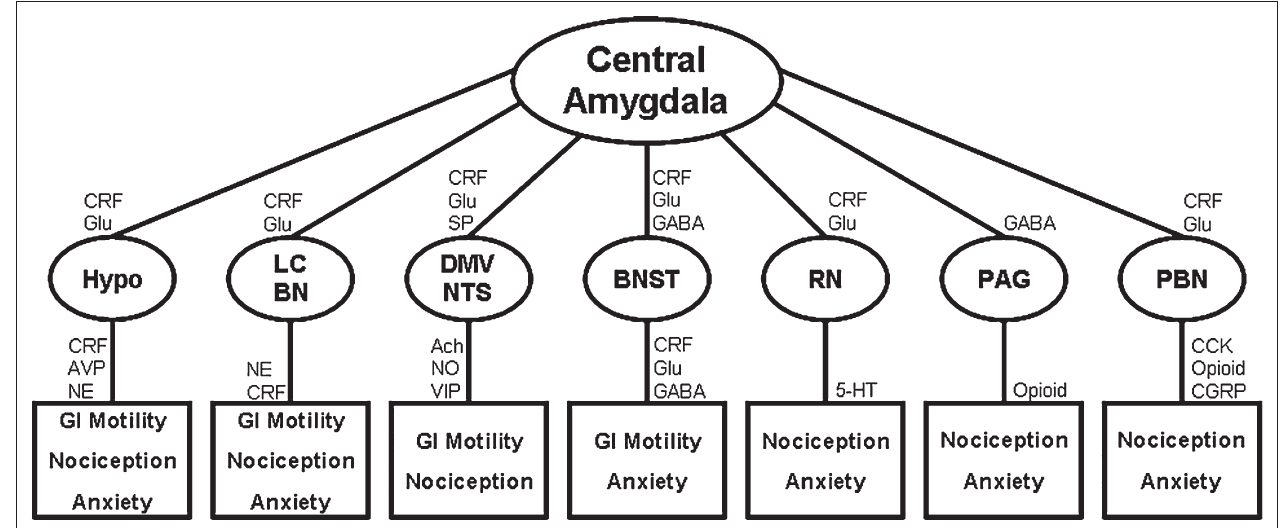
hypothalamus; LC, locus coeruleus; NE, norepinephrine; NO, nitric oxide; NTS, nucleus of the solitary tract; PAG, periaqueductal gray; PBN, parabrachial nucleus; RN, raphe nuclei; SP, substance P; VIP, vasoactive intestinal peptide; 5-HT, serotonin (Choi et al., 2007; Davis, 1997; Gray and Magnuson, 1987;